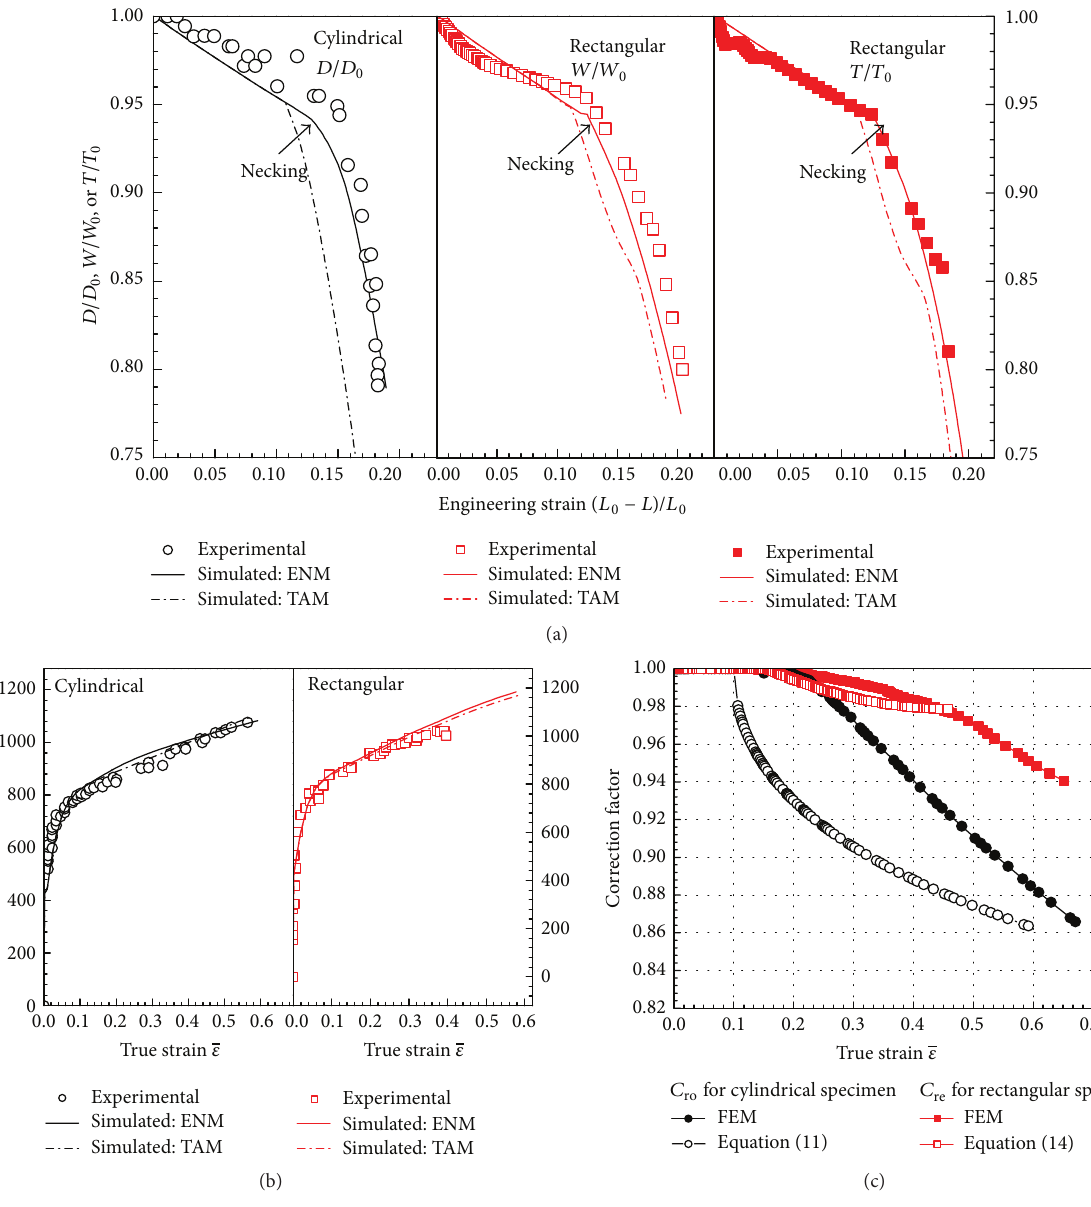
Figure 7: (a) Ratio of current to initial transversal dimensions versus axial elongation. (b) Mean true axial stress versus true strain. (c) Correction